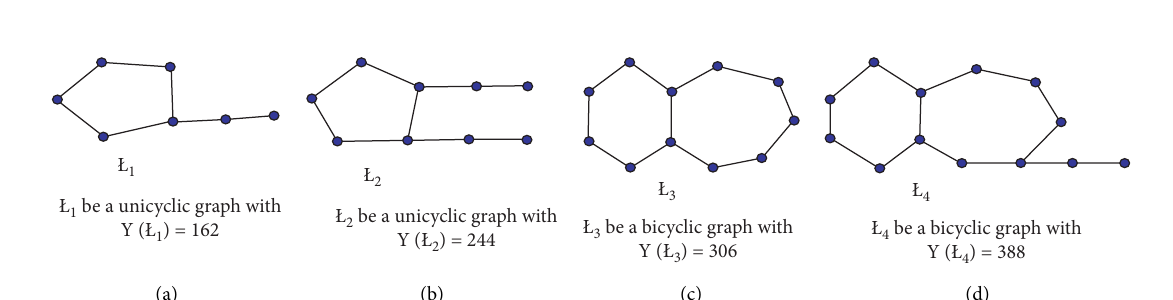
Figure 3: The graphs Ł ) � 244, (c) let Ł with Y ( Ł 3